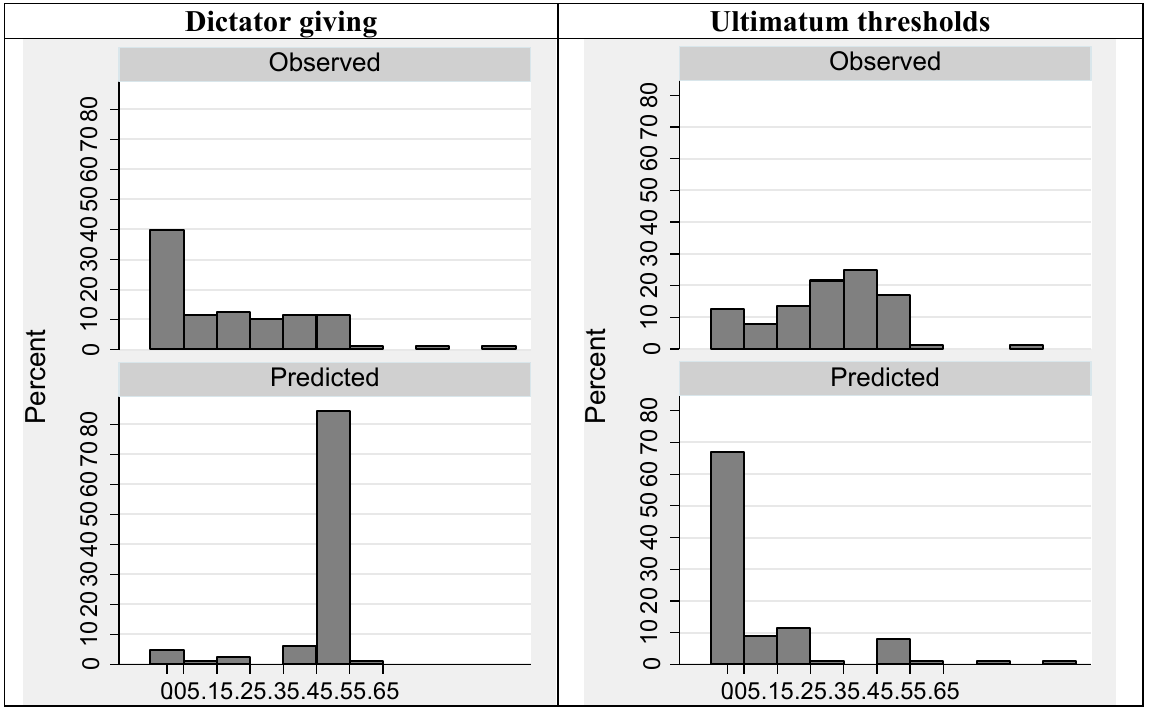
Figure 2. Observed and predicted data on the aggregate